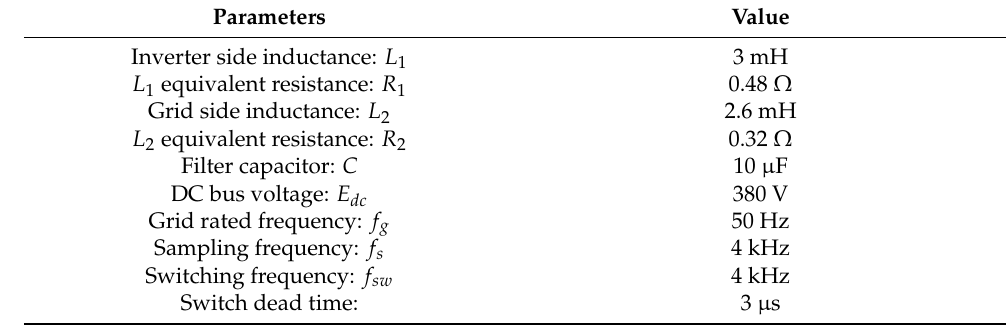
Table 2. Parameters of the FO-PIMR-RC.